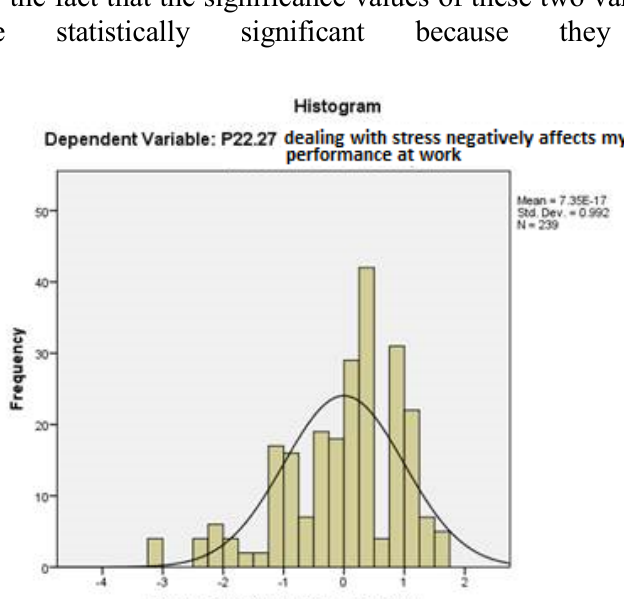
Fig. 5. Histogram. Source: The authors’